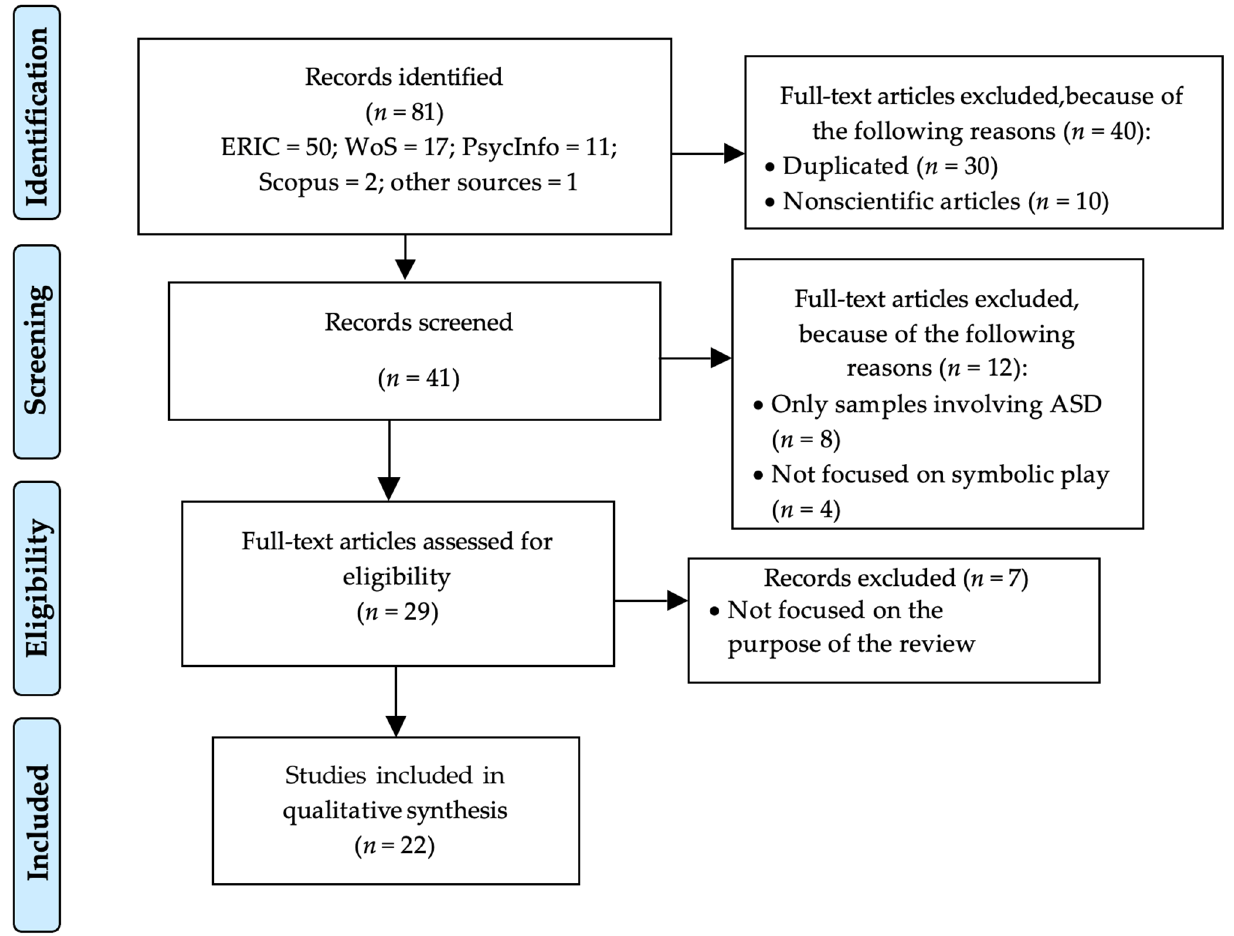
Figure 1. Flow diagram (according to PRISMA) used in this scoping review. Abbreviations included in the figure: ASD: Autism Spectrum Disorder; ERIC: Education Resources Information Center; WoS: Web of Science.